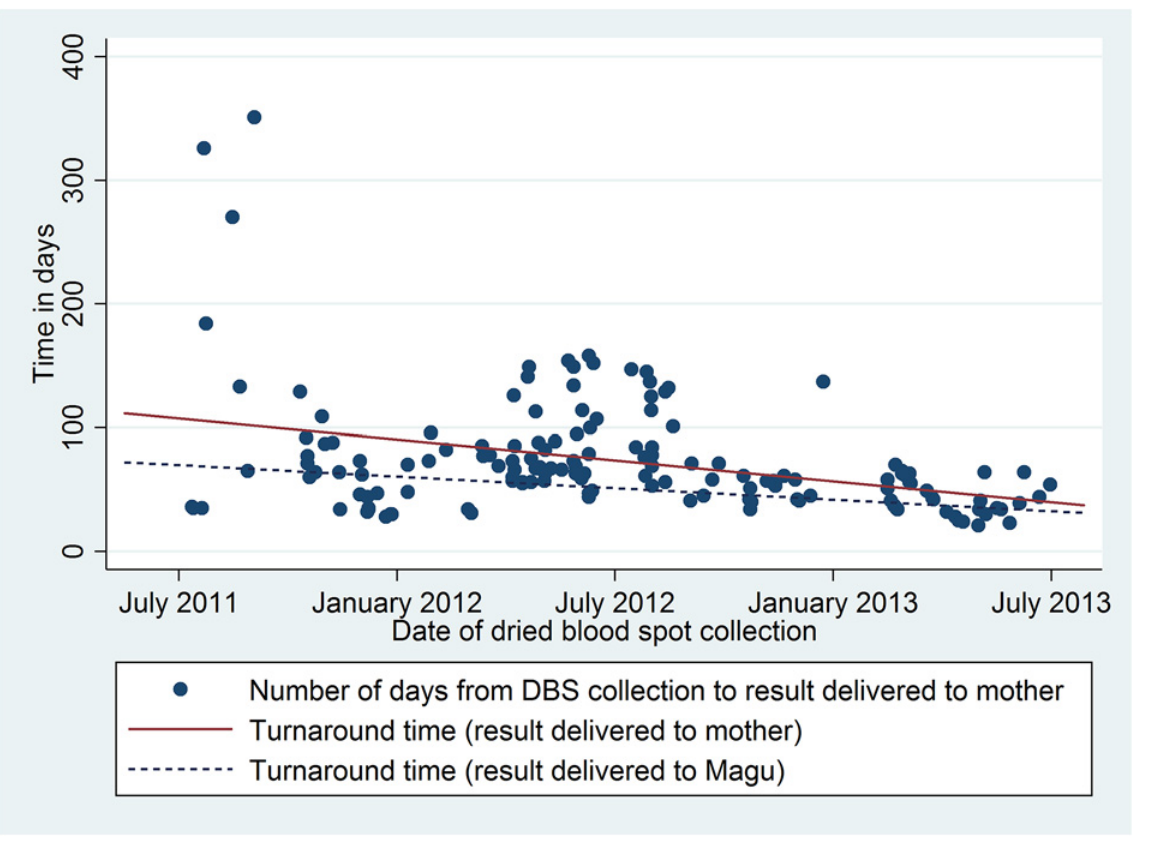
Fig 2. Turnaround times from dried blood spot collection until result available at health center (blue dashed line) or result given to mother (red solid